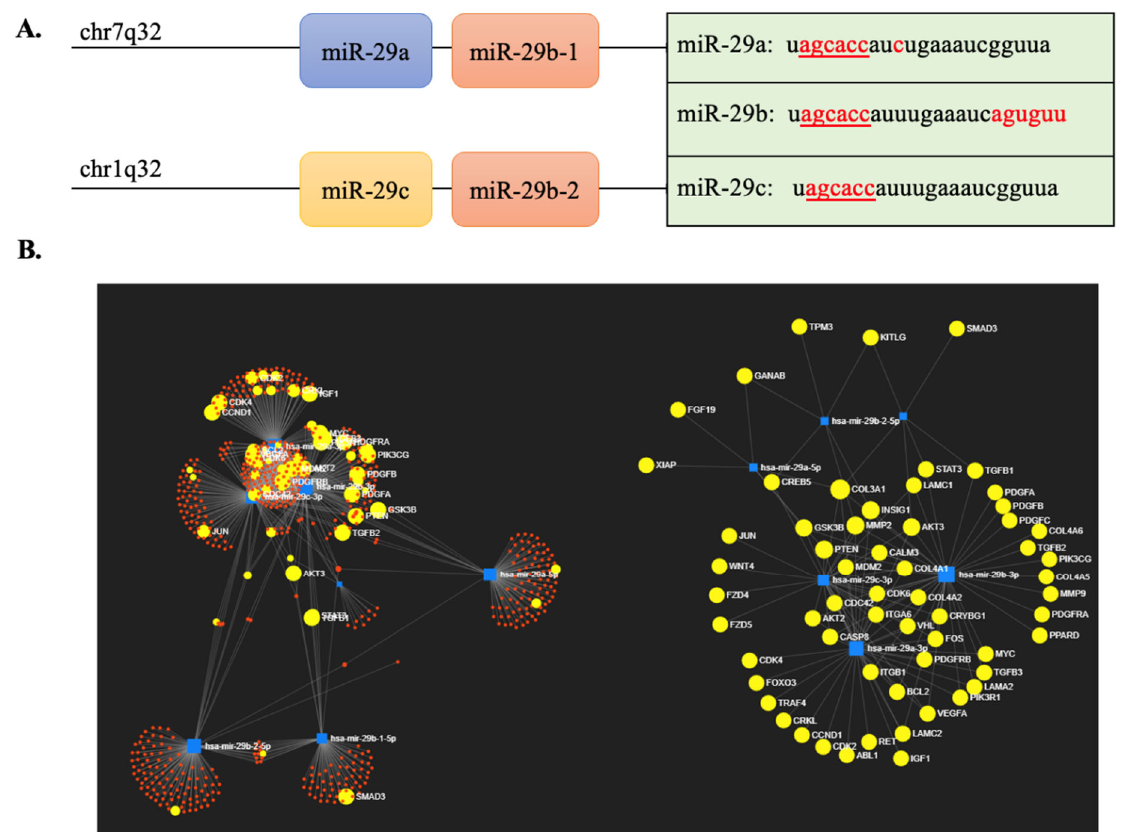
Figure 1. The miR-29 family members and their potential targets. ( A ) Mature sequences and Figure 1. The miR ‐ 29 family members and their potential targets. ( A ) Mature sequences and chromosomal locations of miR ‐ 29s. MiR ‐ 29a/miR ‐ 29b ‐ 1 cluster is located in chr7q32, whereas miR ‐ chromosomal locations of miR-29s. MiR-29a/miR-29b-1 cluster is located in chr7q32, whereas miR- 29b ‐ 2/miR ‐ 29c is in chr1q32. The mature miR ‐ 29s share a common seed region (agcacc) but are 29b-2/miR-29c is in chr1q32. The mature miR-29s share a common seed region (agcacc) but are different at the cytosine position in miR ‐ 29a and a nucleotide sequence at the end of miR ‐ 29b different at the cytosine position in miR-29a and a nucleotide sequence at the end of miR-29b (aguguu) (aguguu) which is known for nuclear localization. ( B ) The potential targets of miR ‐ 29s. The which is known for nuclear localization. ( B ) The potential targets of miR-29s. The visualization is visualization is based on miR ‐ 29s’ experimental targets of the miRNet platform based on miR-29s’ experimental targets of the miRNet platform (https://www.mirnet.ca, accessed (https://www.mirnet.ca, accessed on 24 July, 2022). Each dot represents a gene. The yellow dots on 24 July 2022). Each dot represents a gene. The yellow dots indicate the target genes involved in indicate the target genes involved in cancer pathways. cancer